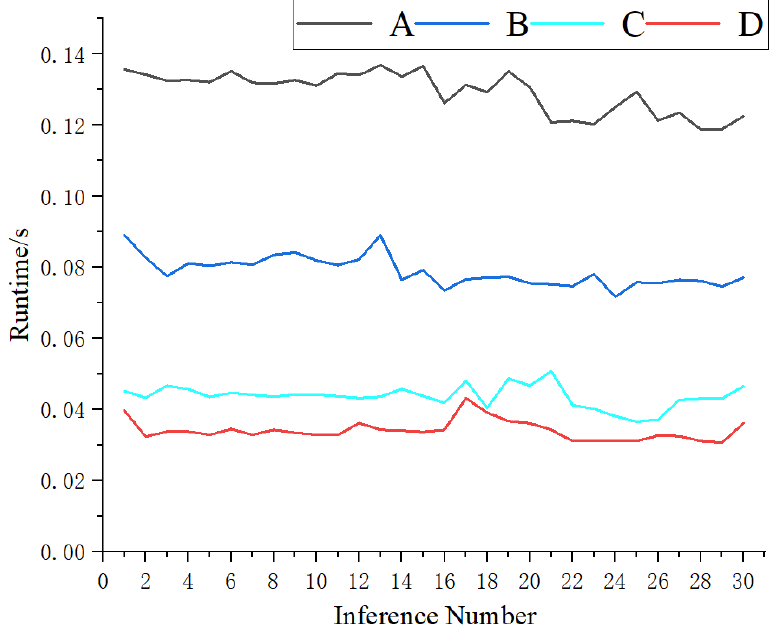
Figure 13. Comparison of running time between single-target area and multi-target area. ( A ) ShuNet inference for multi-target regions, ( B ) ShuNet inference for single-target regions, ( C ) ShuEng inference for multi-target regions, and ( D ) ShuEng inference for single-target regions. Table 5. Comparison of average inference time between single-target regions and multi-target regions.